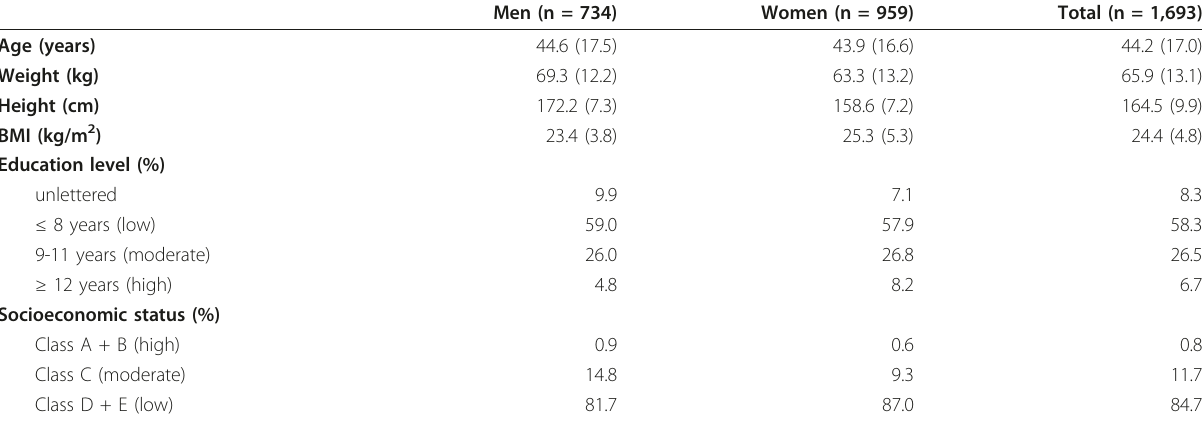
Table 1 Anthropometric and sociodemographic characteristics of the study